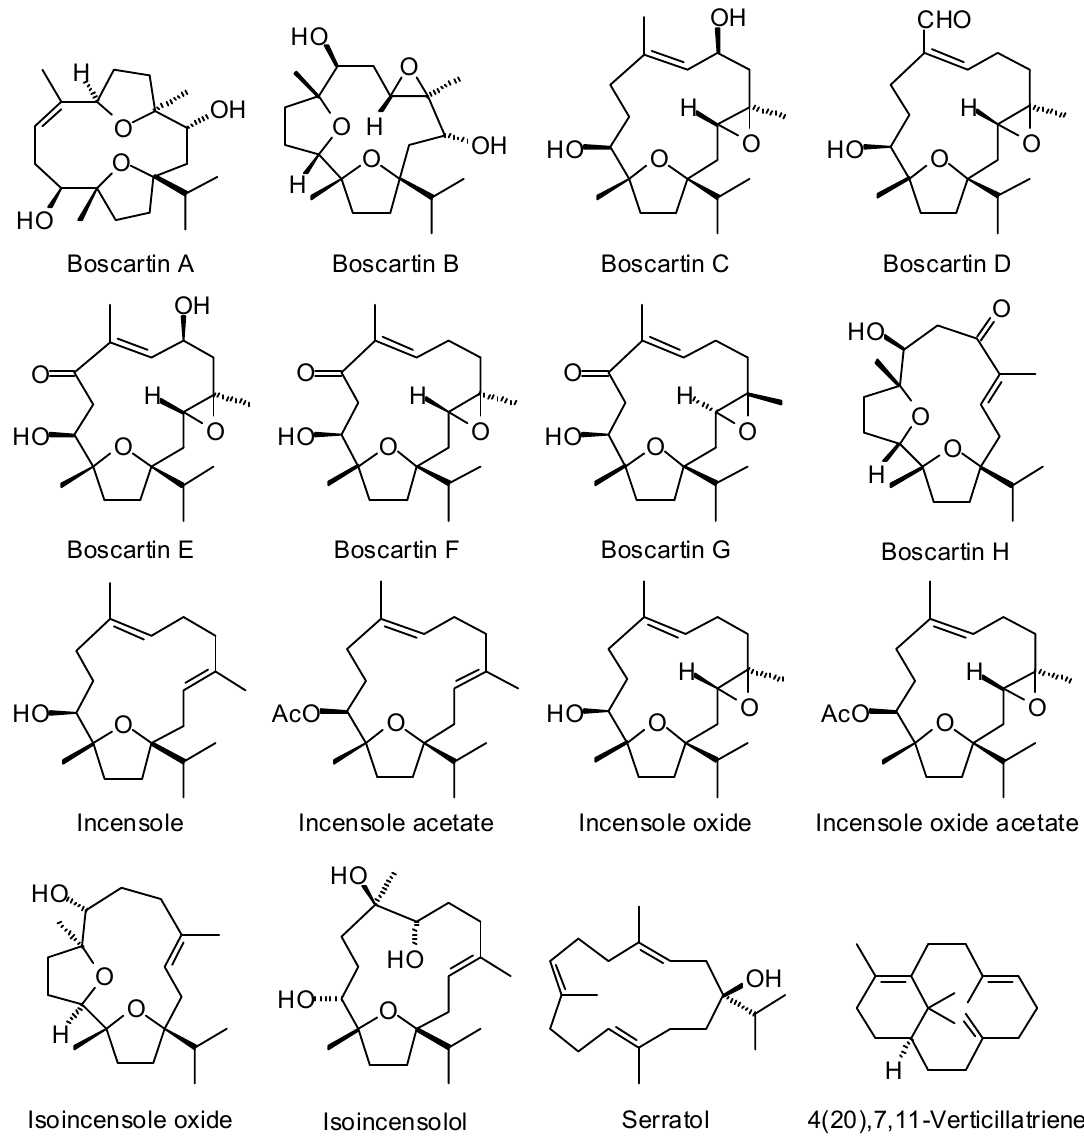
Figure 1. Macrocyclic diterpenoids found in Boswellia species.